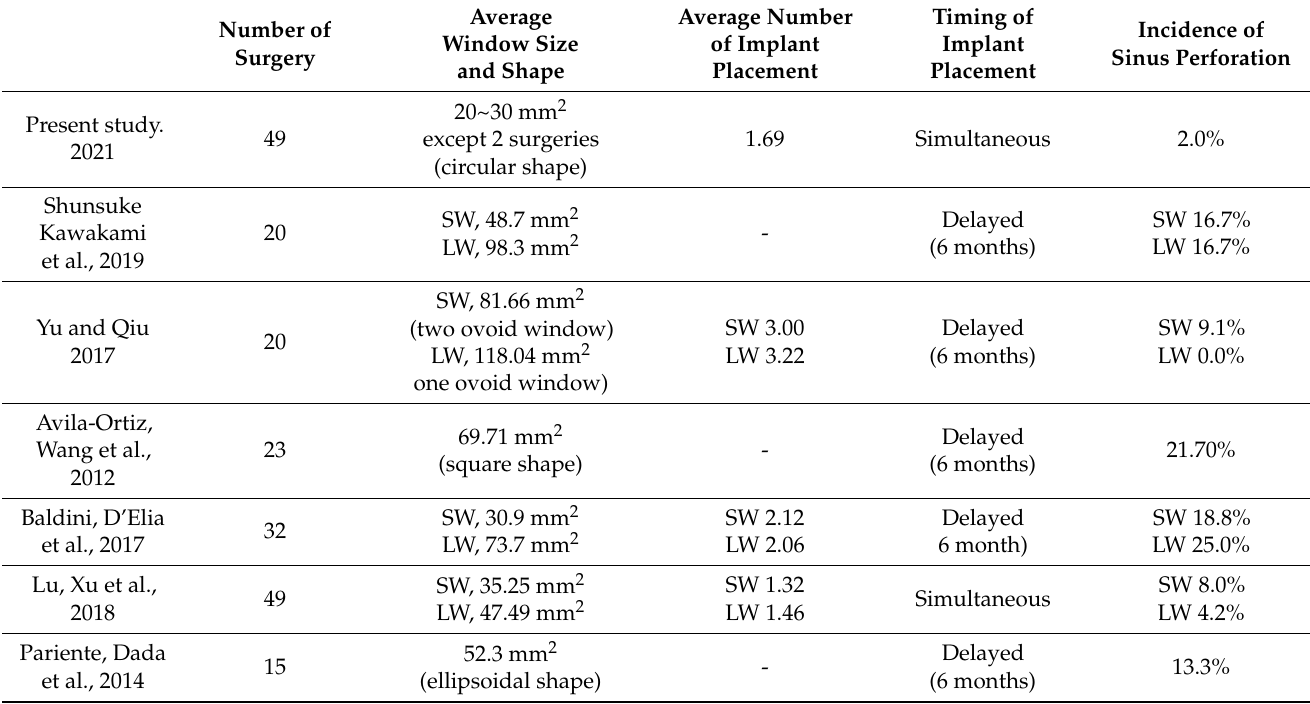
Table 2. Literature review of lateral window size and shape in maxillary sinus floor elevation. Number of Surgery